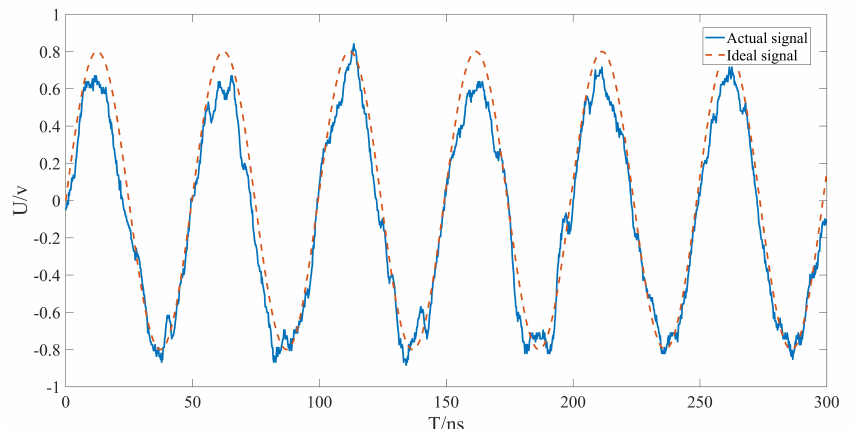
Figure 1. Comparison between the measured signal after photoelectric conversion and the ideal signal.